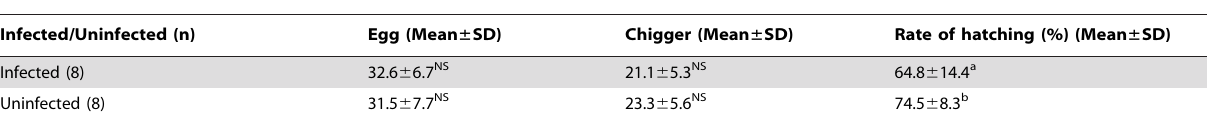
Table 3. Fecundity and hatching rate of Leptotrombidium palpale .